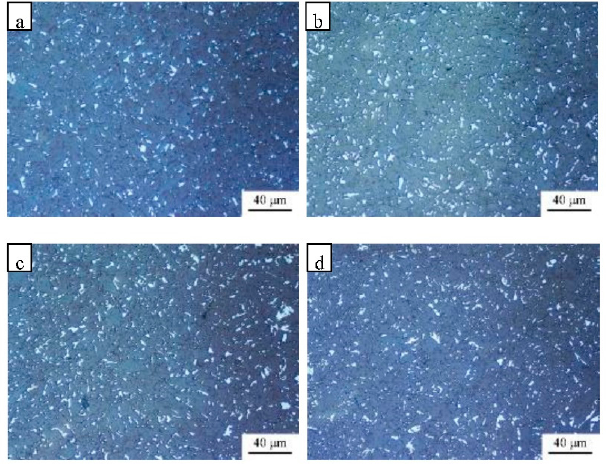
Figure 5. Typical optical micrographs of M/A constituents comprising ( a ) 0.15 wt.% Si, ( b ) 0.36 wt.% Si, ( c ) 0.48 wt.% Si, and ( d ) 0.77 wt.% Si.